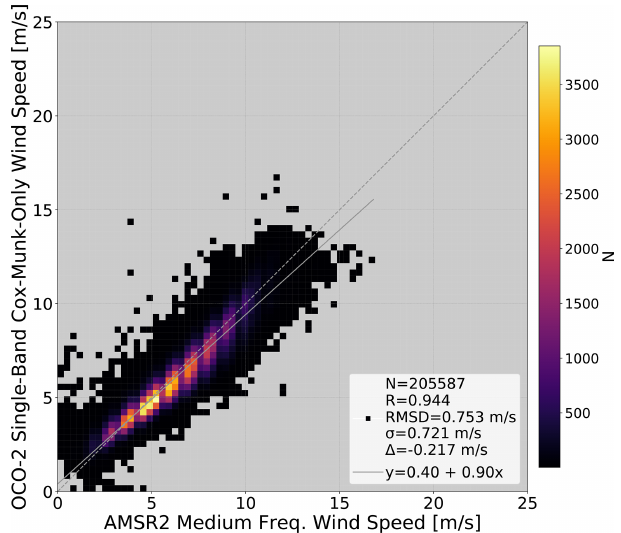
Figure 6. Heatmap of OCO-2 single-band Cox–Munk-only wind speed compared to AMSR2 medium-frequency wind speed. The B9 lite file quality flag, custom filtering, and height scaling have been applied. The TSIS solar continuum is used. N is the number of re- trievals, R is the correlation coefficient, RMSD is the root mean square deviation of the two datasets, σ is the standard deviation be- tween the two datasets, (cid:49) is the mean difference, the dashed line is a one-to-one line, and y is a linear fit plotted as a solid